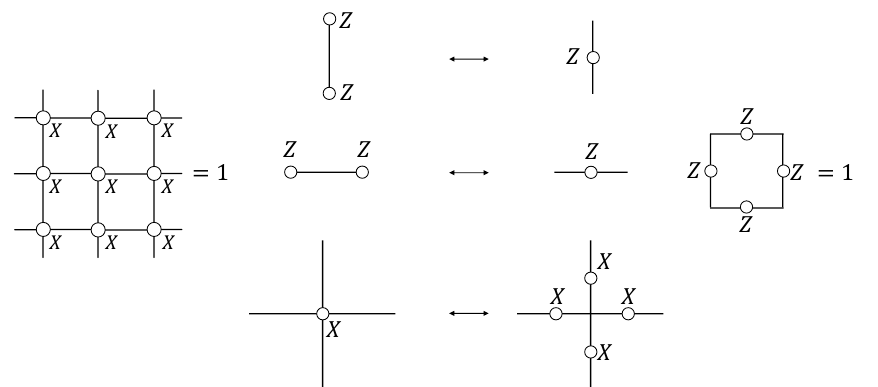
Figure 5: Gauging (cid:90) We consider the symmetric sector of the Hilbert space: erators are generated by the single X Hilbert space contains qubits at all edges, with the gauge constraint each face f . For non-simply connected manifolds, there are additional constraints that the product of Z